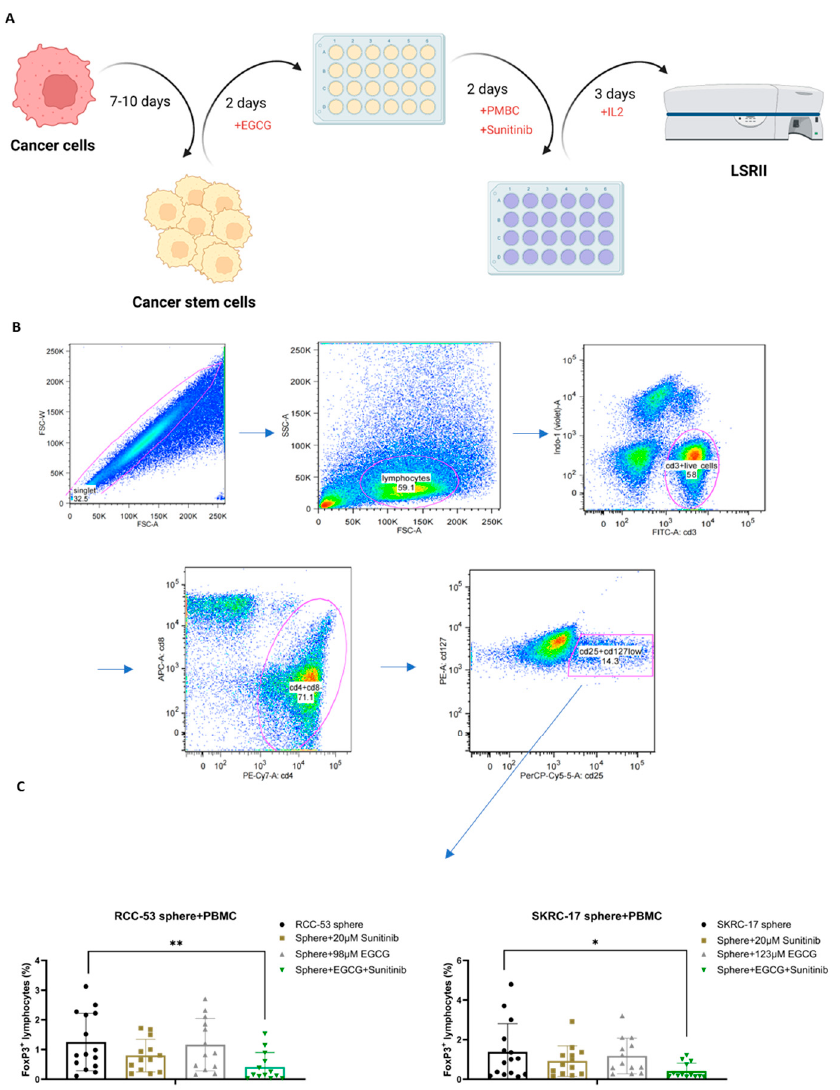
Figure 11. The Treg cells were significantly decreased by the combination treatment EGCG plus sunitinib in co-culture with CSCs. ( A ) Workflow of the MLTC system. ( B ) Representative plots showing the gating strategy for Treg analysis. ( C ) Percentages of FoxP3 + CD25 + CD127 low lymphocytes among the CD4 + T cells (* p < 0.05, ** p <